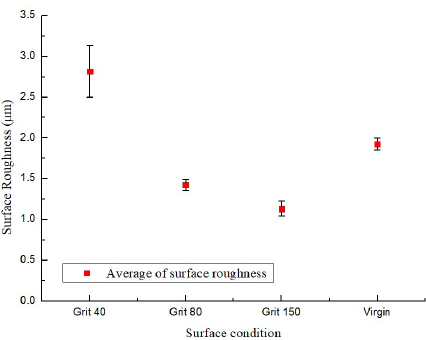
Figure 11. Average surface roughness according to the condition of the grinder